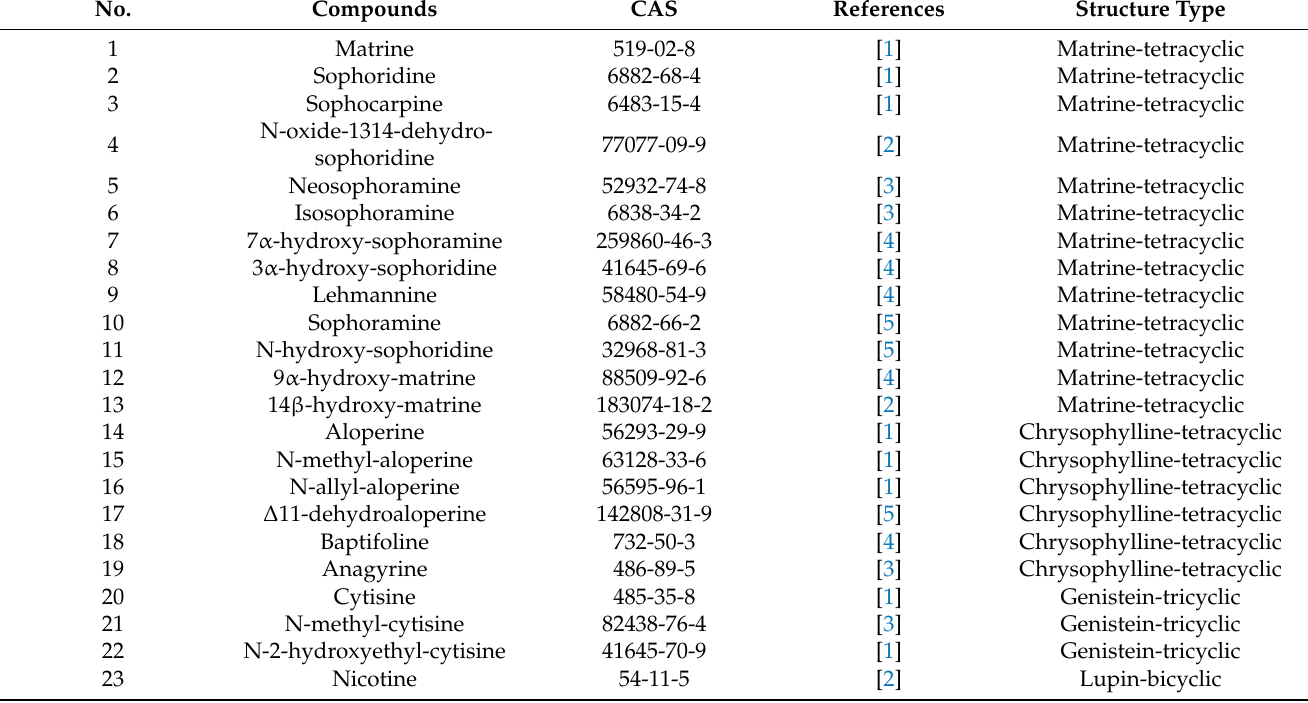
Table 1. Parts of alkaloids that have been isolated from S. alopecuroides